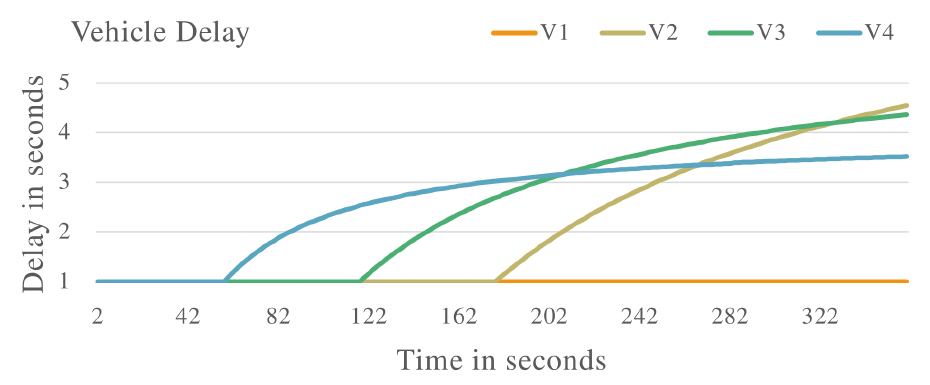
Figure 7. Vehicle delay with malicious vehicles that are delaying packets in the VANET.